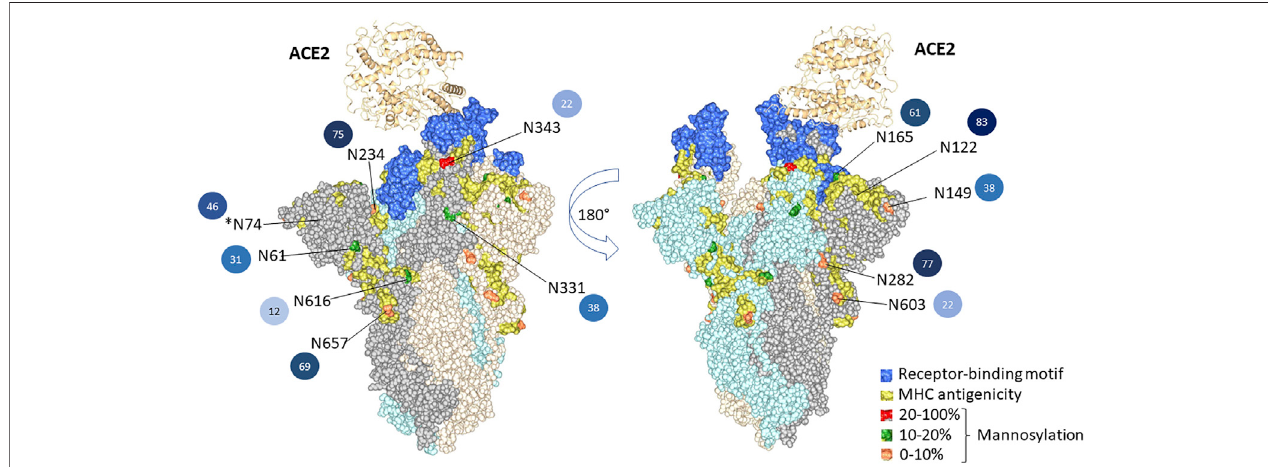
FIGURE 5 | 3D structural modeling of spike glycosylation microheterogeneity. The N-glycosites are mapped on the SARS-CoV-2 trimer structure (PDB code 7A96). Blue indicates the receptor-binding motif in the RBD region. Yellow indicates the predicted MHC antigenic sites. The glycosites are colored according to the mannosylation percentage. The number of glycoforms at each site from less to more heterogeneous glycoforms detected is colored by light to dark, and the number is also listed.